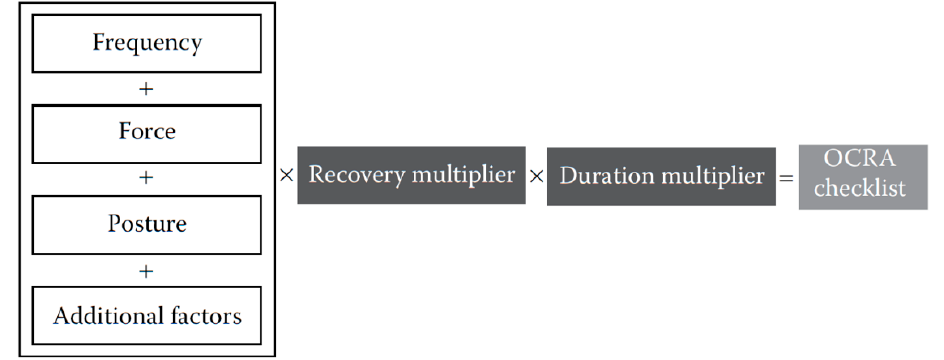
Figure 2. Calculation of risk factors of the OCRA Checklist method.